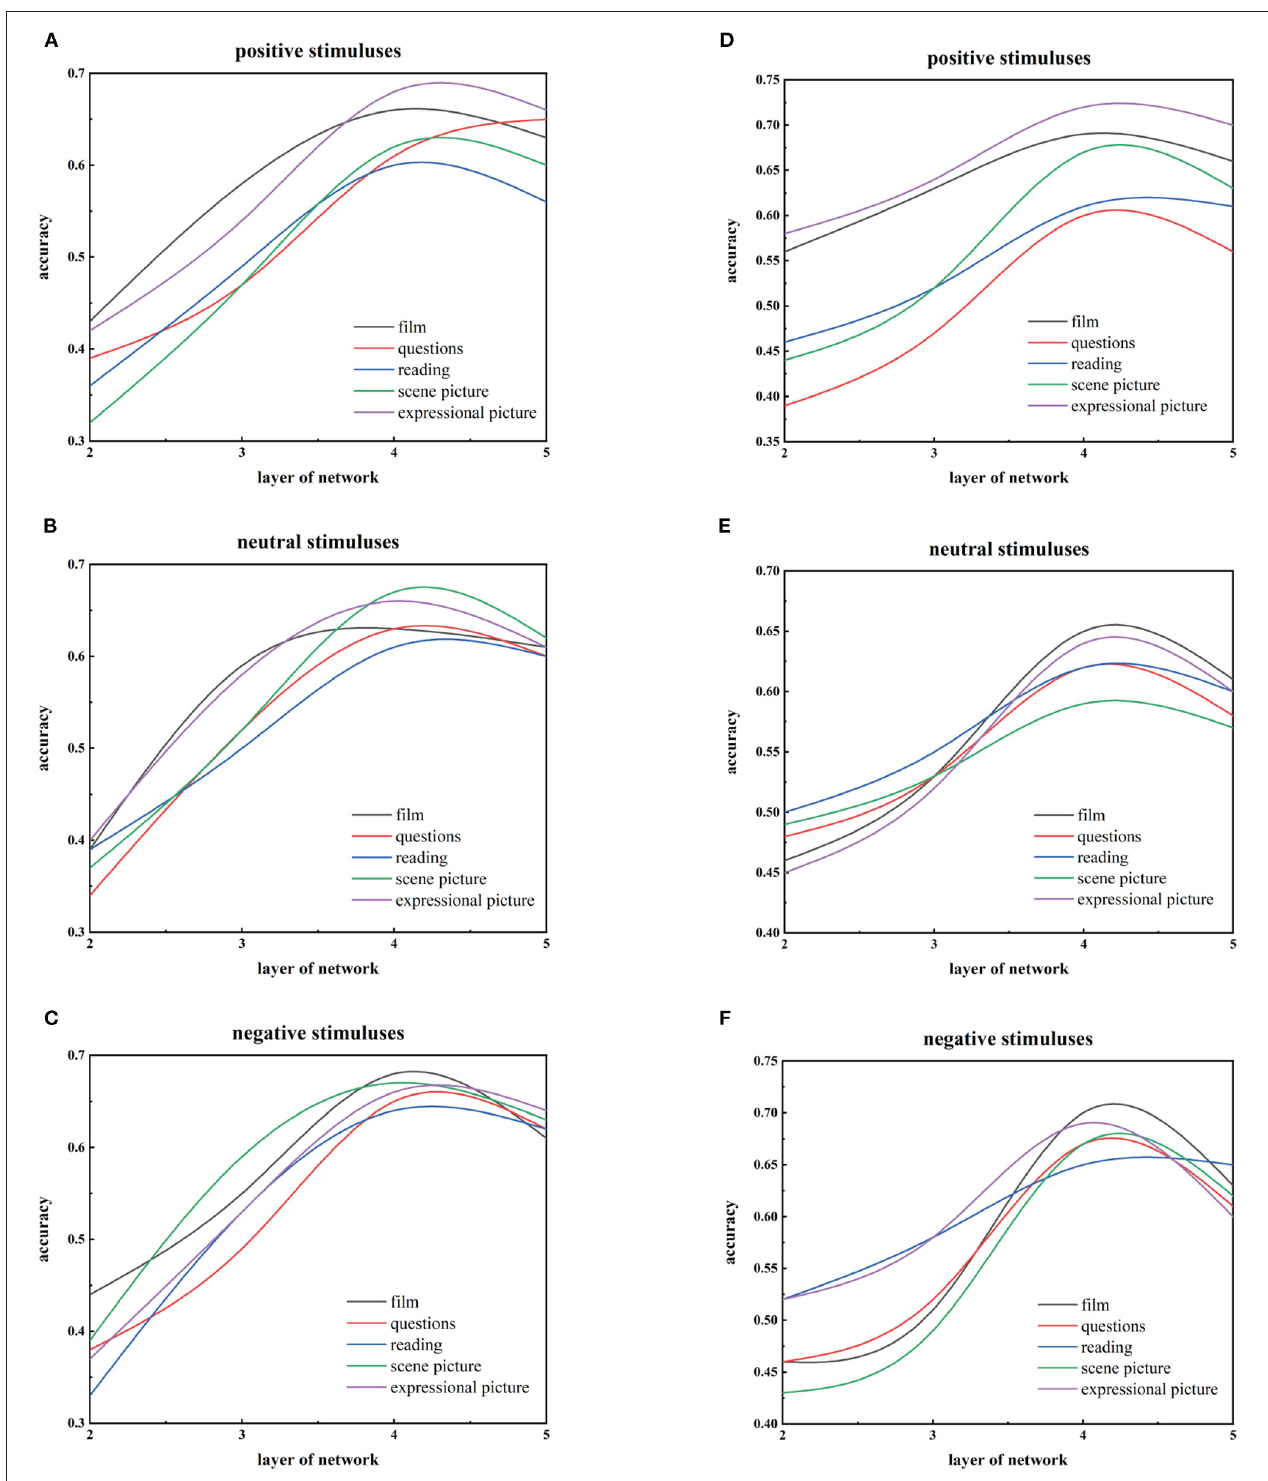
FIGURE 9 | Comparison of recognition performance with the different hidden levels on three emotional valences of the five stimuli for 3D facial points and 2D images. (A–C) are based on 3D facial points. (D–F) are based on 2D images.